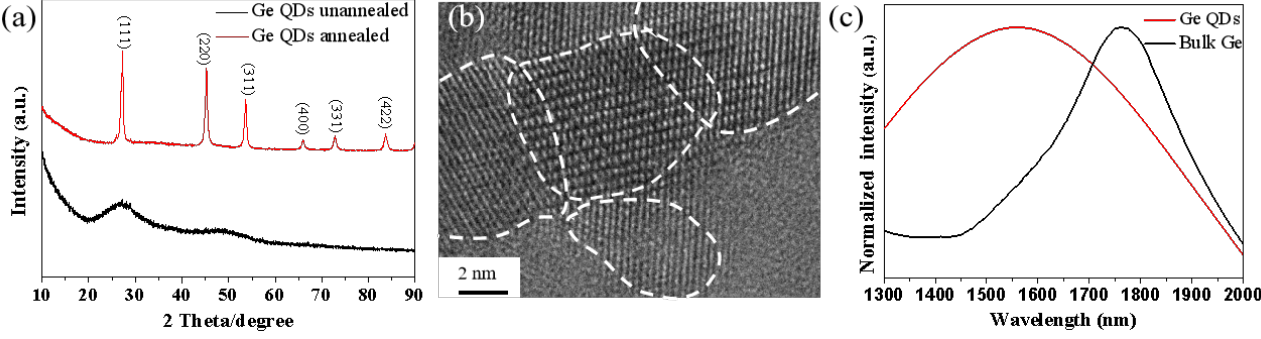
Figure 3. ( a ) XRD results of Ge QDs before and after annealing. ( b ) TEM image of annealed Ge QDs. ( c ) The PL spectra of annealed Ge QDs and bulk Ge wafer.